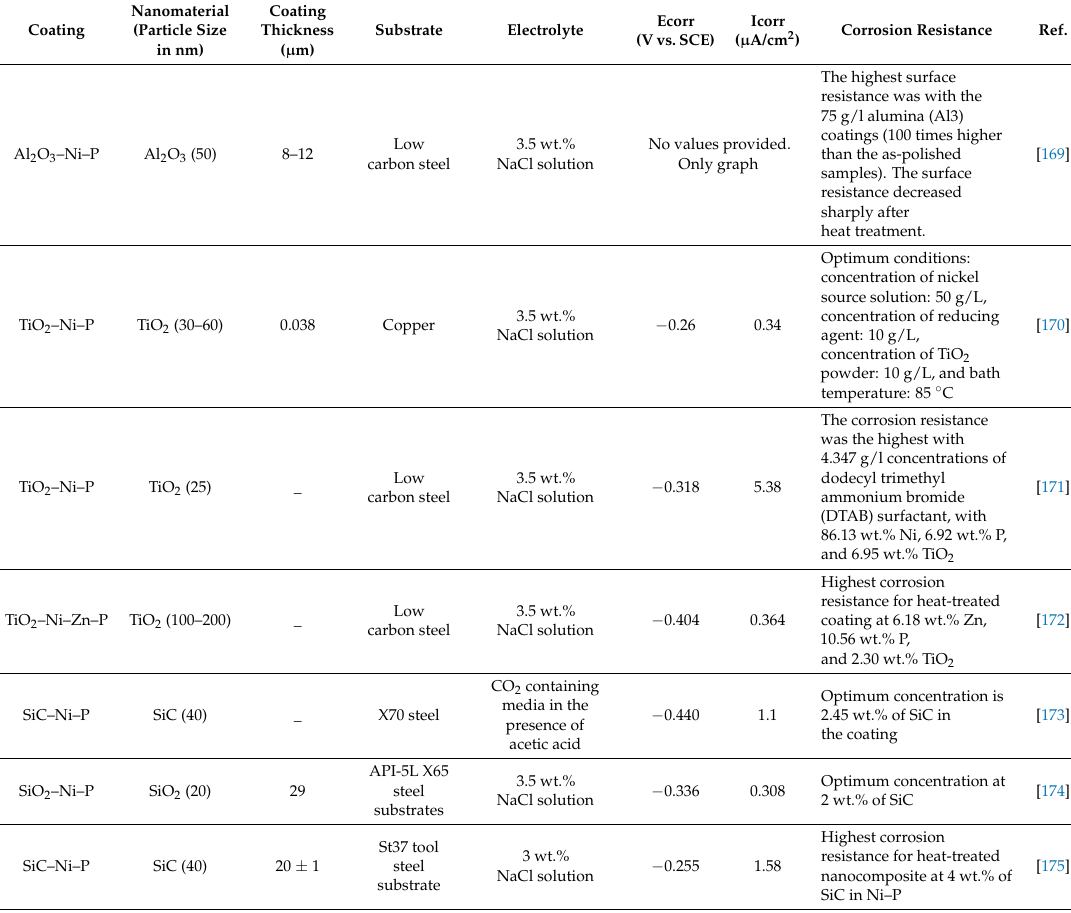
Table 5. Summary for some corrosion parameters of electroless nickel alloy nanocomposite coatings.